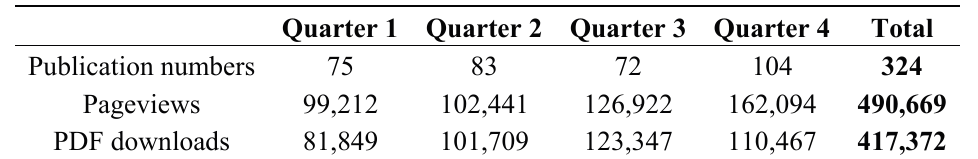
Table 2. Pageviews and PDF downloads per quarter in 2013. Those figures increased with the growing publication numbers per quarter in